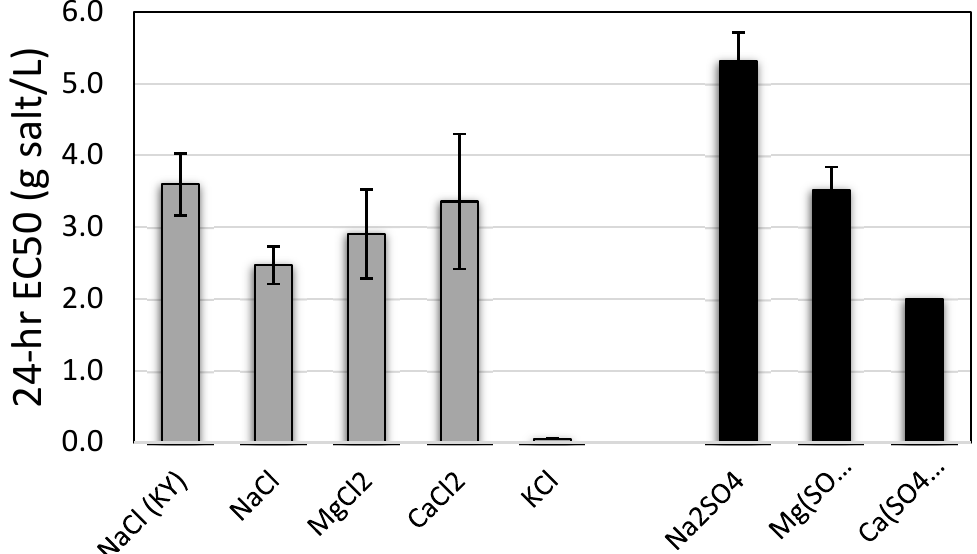
Figure 1. Twenty-four-hour EC50s for Lampsilis siliquoidea glochidia exposed to chloride (gray bars) or sulfate (black bars) salts in moderately hard water (hardness 80–90 mg/L) at 20 °C. Origin of glochidia was Missouri, USA, except for one batch noted from Kentucky (KY). Error bars represent 95% confidence limits.